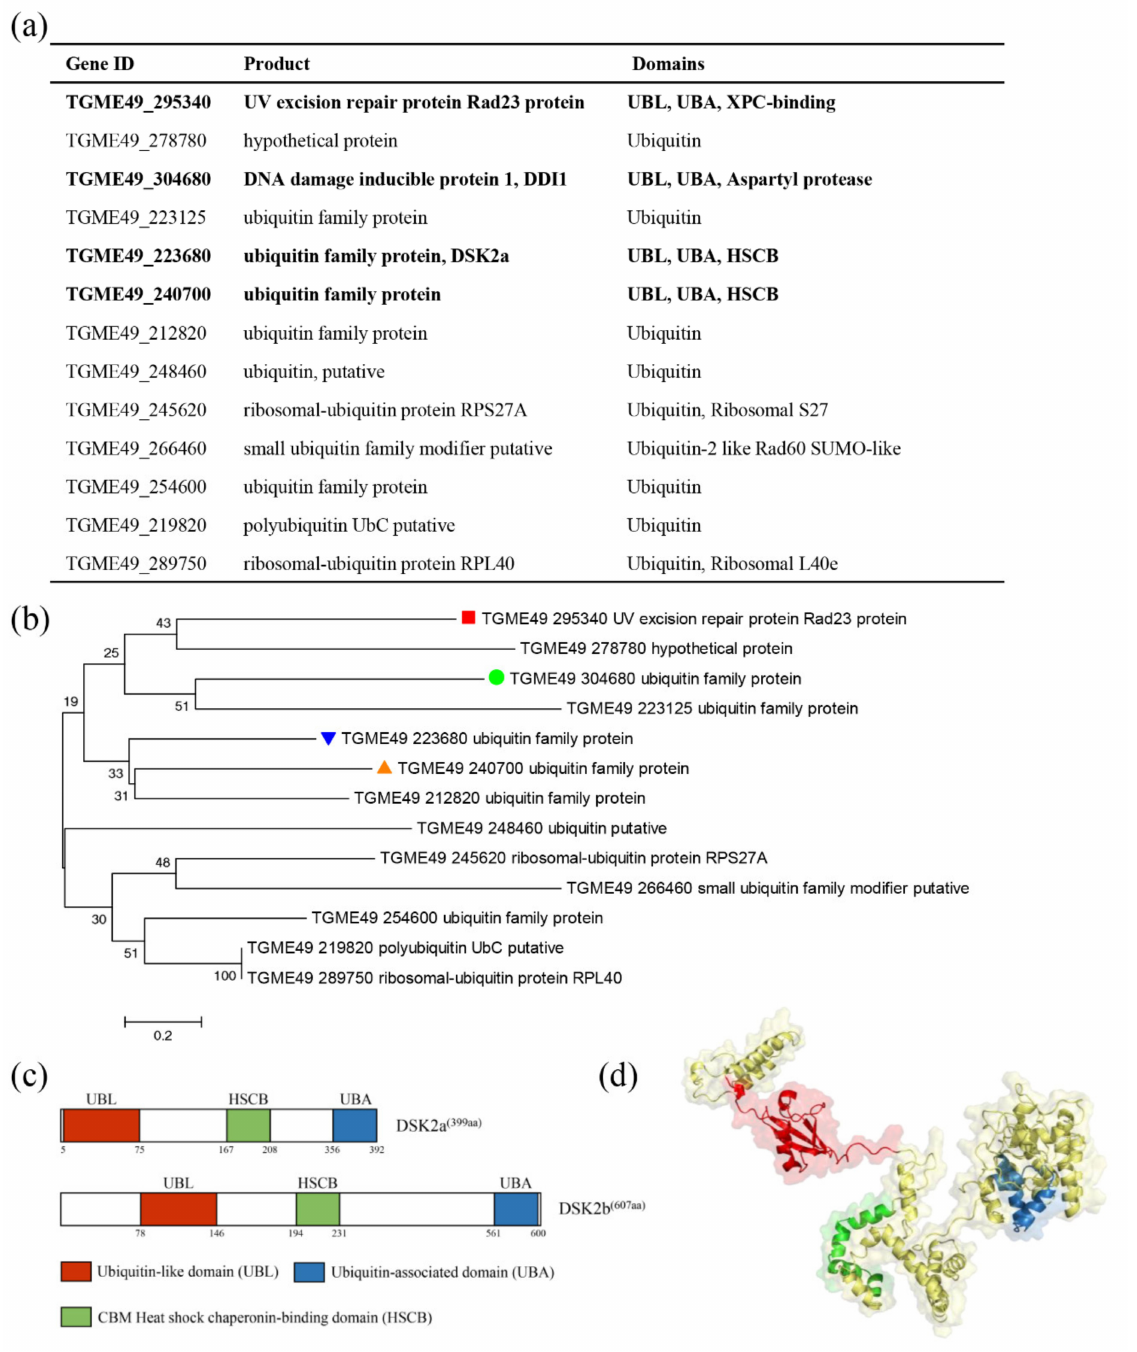
Figure 1. DSK2b is a novel UBL-UBA shuttle protein in T. gondii. ( a ) Proteins identified by BLAST in ToxoDB using ubiquitin as query sequence. Domains predicted by SMART database in these proteins are indicated. Bold font shows the proteins containing UBL and UBA domains. ( b ) Phylogenetic analysis of the identified proteins. The red block, green circle, blue triangle and orange triangle indicate RAD23, DDI1, DSK2a and DSK2b, respectively. ( c ) Domain architecture of DSK2a and DSK2b. UBL, ubiquitin-like domain; UBA, ubiquitin-associated domain; HSCB, CBM heat-shock chaperonin-binding domain. ( d ) The predicted three-dimensional (3D) structures of DSK2b. Several β sheets and an α -helix constitute the classical UBL domain (red); a bundle of three α -helices constitute the classical UBA domain